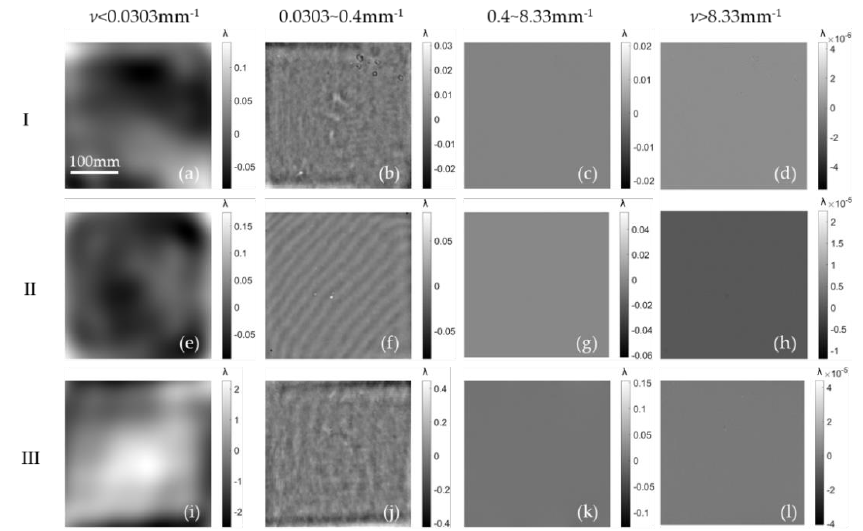
Figure 3. Filtered wavefronts with different spatial frequencies. ( a – d ) represent the wavefront distribution of the low spatial frequency, the PSD-1, the PSD-2, and high spatial frequency of type I, respectively; ( e – h ) and ( i – l ) represent the four wavefronts of type II and type III, respectively, same as ( a – d ). The scale bar is 100 mm, and all subplots are the same size. We normalized the wavefront PV value. When the PV values of the original wave- fronts are 1 λ , and the PV value ratio of each filtered wavefront part is maintained, the PV values of the filtered wavefront are listed in Table 1. From Table 1, for the PV values of the low-spatial-frequency type, the largest is wavefront III, while the lowest is II; for the mid-spatial-frequency type, the results are the opposite. This indicates that the accumu- lated wavefront, wavefront III, has certain complementarity in the mid-frequency types, which is beneficial for a more uniform and smoother wavefront distribution. The follow- ing section quantitatively analyzes the effect of different wavefront types on the focal spot characteristics by varying the PV values. Table 1. PV values of f iltered wavefront types when original wavefront PV = 1 λ . Wavefront Type